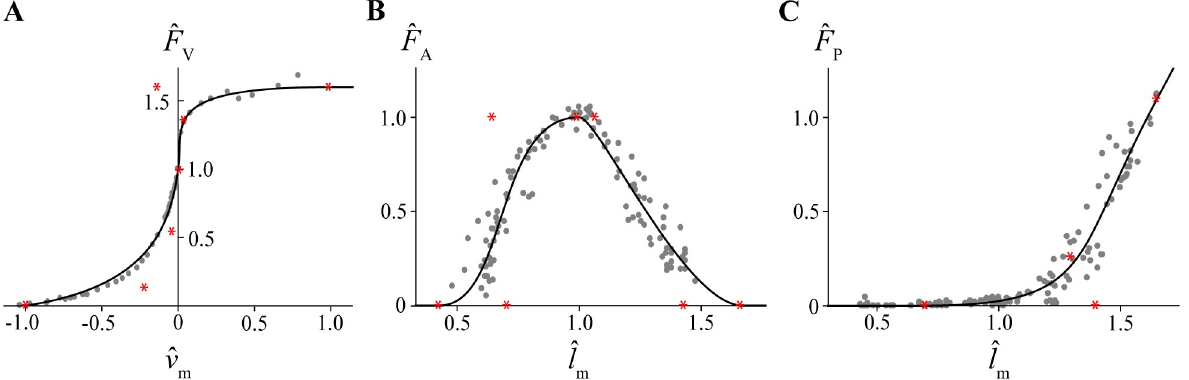
Fig 2. Force-velocity and force-length curves. Normalized force-velocity (A), active force-length (B) and passive force-length (C) curves (black lines). The force-velocity curve and the active and passive force-length curves are fitted to experimental data from [47] and [48], respectively (grey points). The Be´zier control points for each curve are shown as red